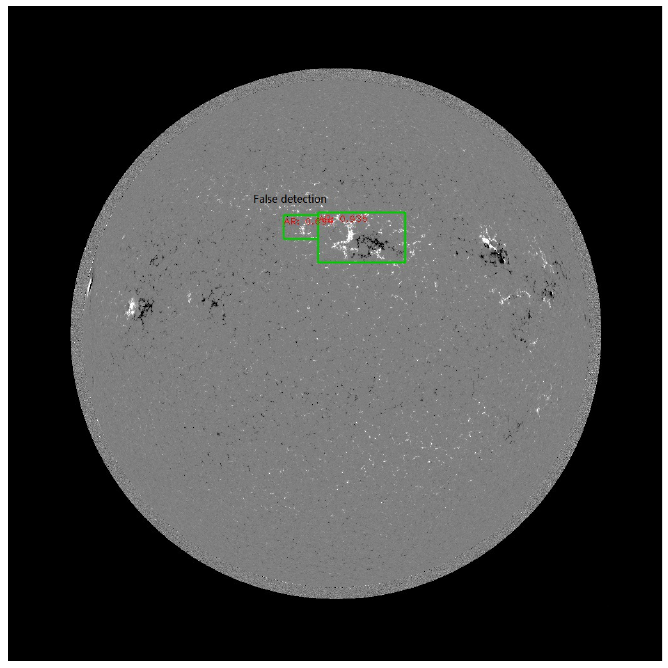
Figure 5. Example of the faster R-CNN detection of active region. Figure 6 shows an example for YOLO V3 detection of active regions in the same period. There are no missed or falsely detected active regions.